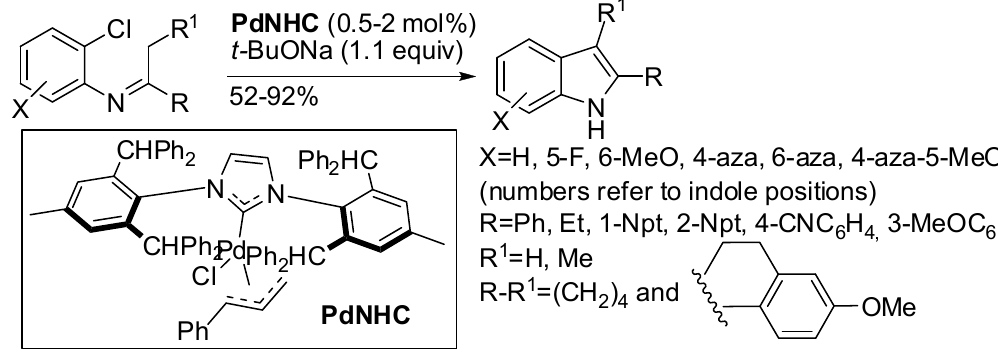
Scheme 28. Pd-NHC catalyzed α -arylation of imines.